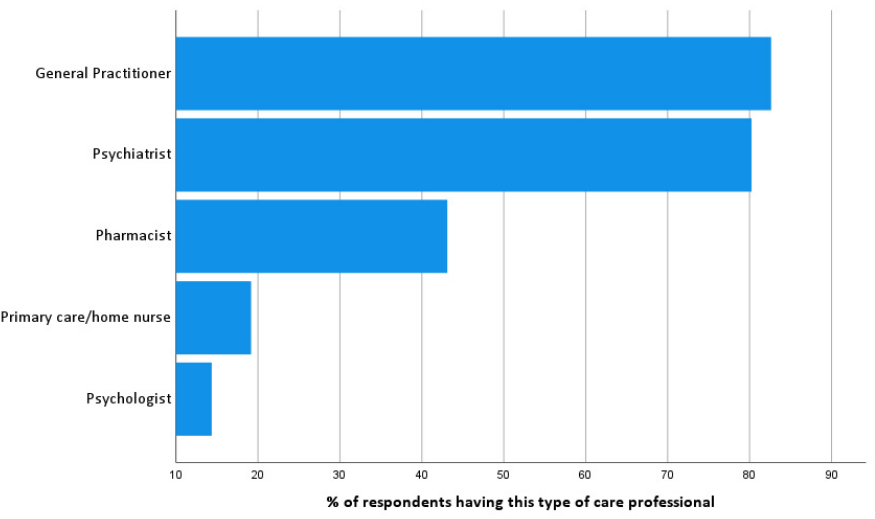
Figure 1. Type of care professionals being present in the respondents ’ personal care network (% of respondents).